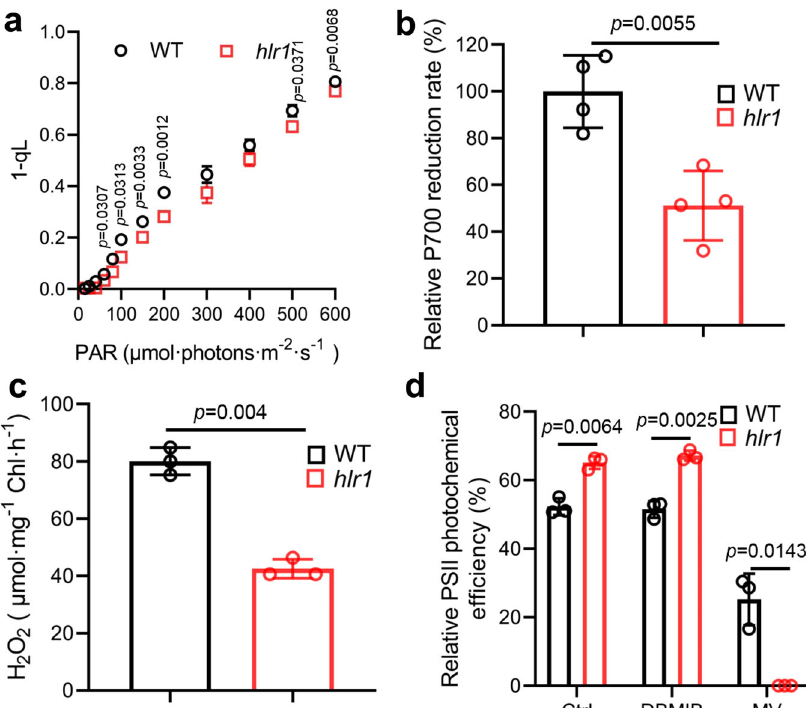
Fig. 4 Altered electron transport in the WT and the hlr1 mutant. a Redox state of the PQ pool (1-qL). b Relative P700 + re-reduction rate. c Net production of H 2 O 2 during 1 h high-light treatment. d Effects of MV and DBMIB on HL-induced PSII photoinhibition. Cells were incubated in HL for 12 h in the presence or absence of 1 μ M DBMIB or 1 mM MV. Data are presented as the means ± SD ( n = 3 for a , c , and d ; n = 4 for b ). The P values with signi fi cance are shown.